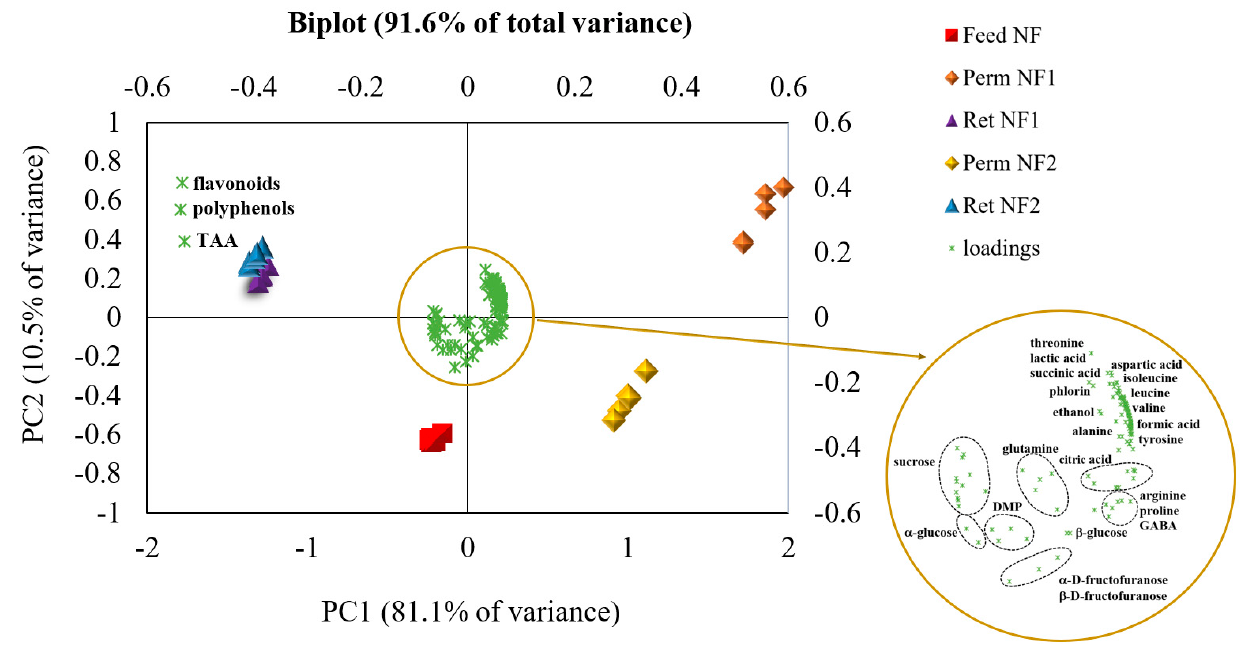
Figure 10. Principal component analysis biplot of the studied NF samples. The location of NMR- variables is indicated by the circle in which the assignments of the loadings are shown.